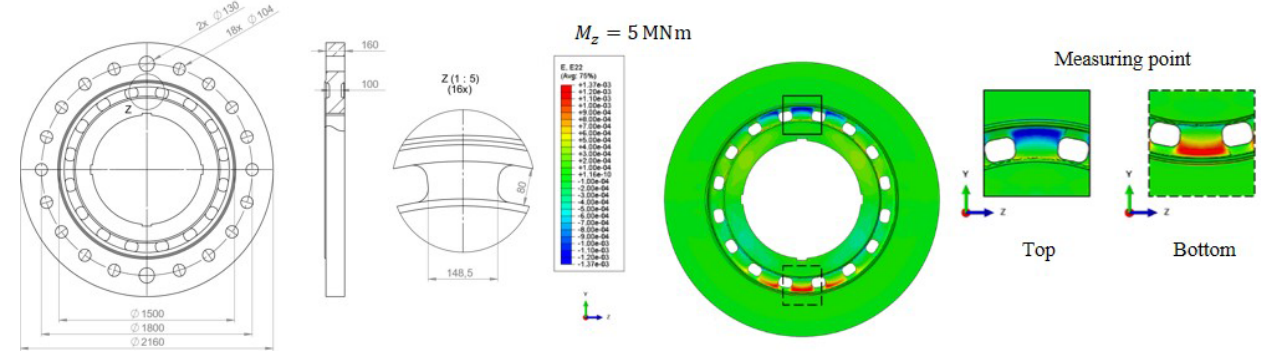
Figure 13. Bending element dimensions and the distribution of the nominal strain in the y direction at the measuring point of the bending moment under nominal bending of